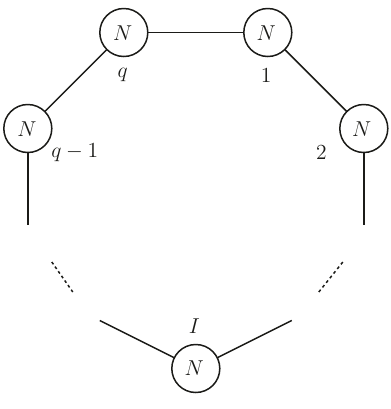
Figure 1 . A q − 1 theories as circular quivers with q gauge